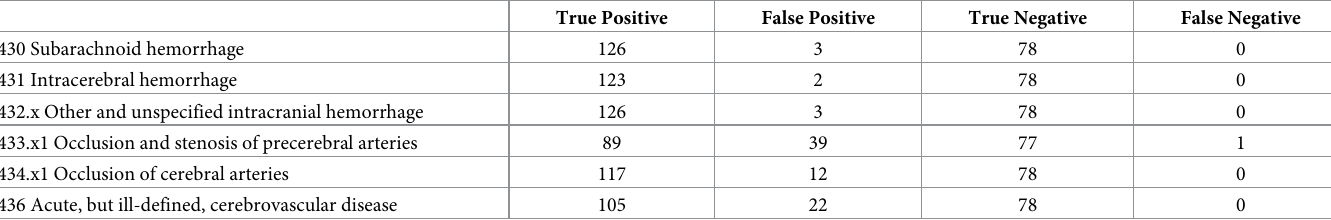
Table 8. Cross tabulation of the index test (ICD-9-CM code) for the results of the reference standard (medical chart).